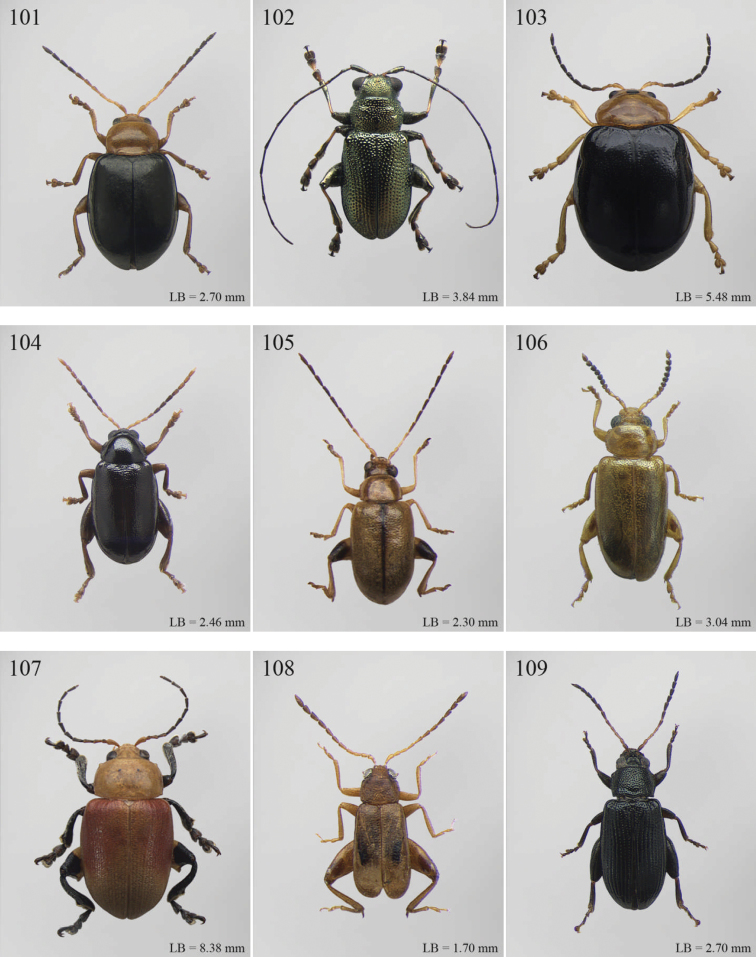
Habitus. 101
Stuckenbergiana glabrata (Jacoby) 102
Terpnochlorus perrieri Fairmaire 103
Toxaria indica (Fabricius) 104
Trachytetra guineensis (Bechyné) 105
Tritonaphthona longicornis (Laboissière) 106
Upembaltica scolytina Bechyné 107
Xanthophysca perrieri Fairmaire 108
Yemenaltica scorteccii Scherer 109
Zomba gossypii Bryant.